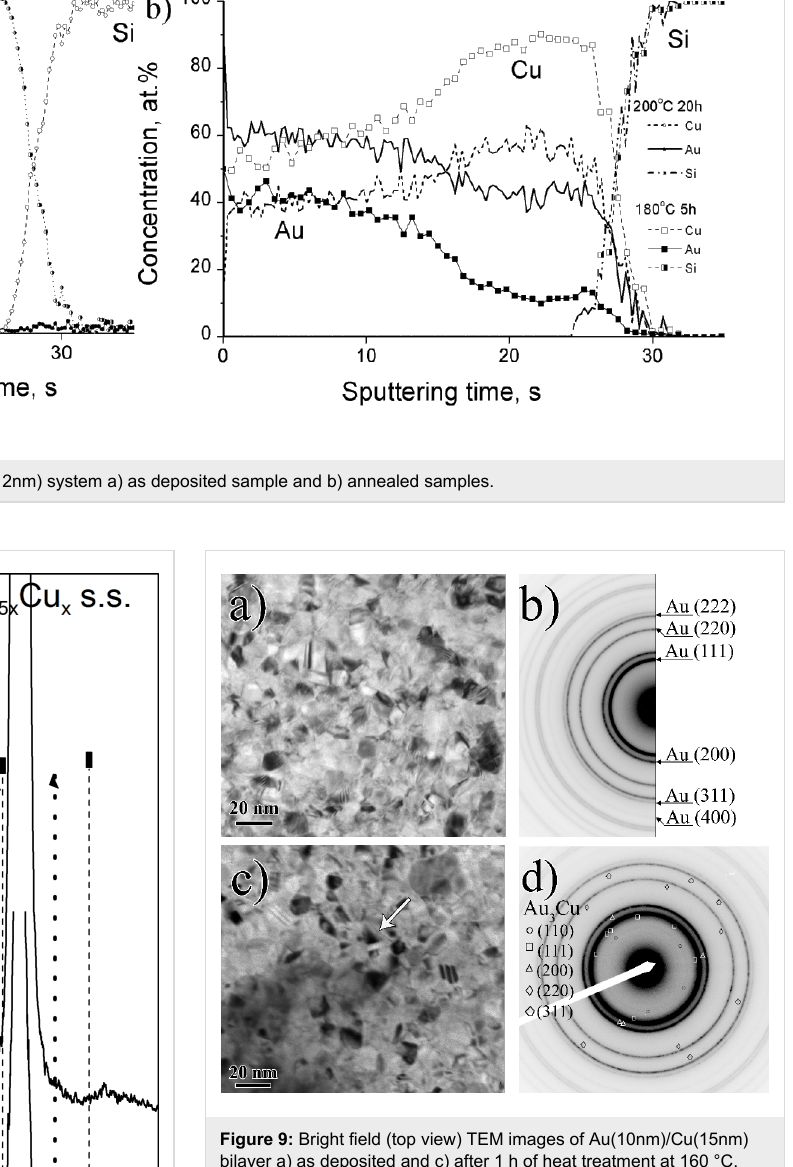
Figure 9: Bright field (top view) TEM images of Au(10nm)/Cu(15nm) bilayer a) as deposited and c) after 1 h of heat treatment at 160 °C. The arrow indicates the area of formation of a new phase. Selected area electron diffraction patterns of Au(10nm)/Cu(15nm) bilayer b) as deposited and d) after 1 h of heat treatment at 160